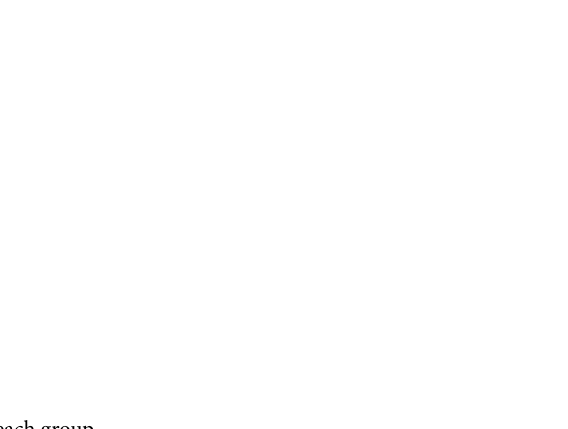
Table 1. Appearance status rating of mice in each